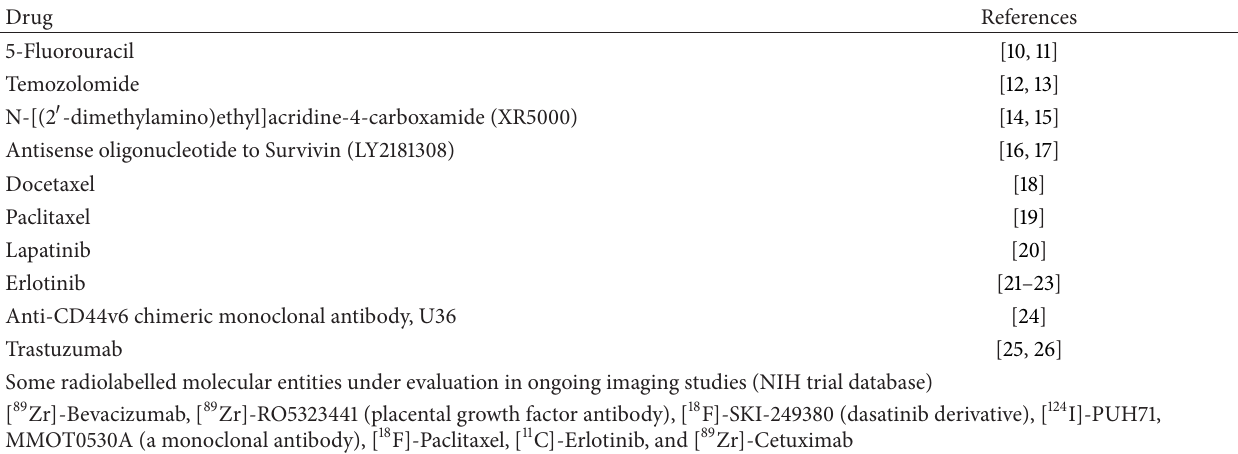
Table 1: Examples of some the clinical PET biodistribution studies performed with radiolabelled anticancer